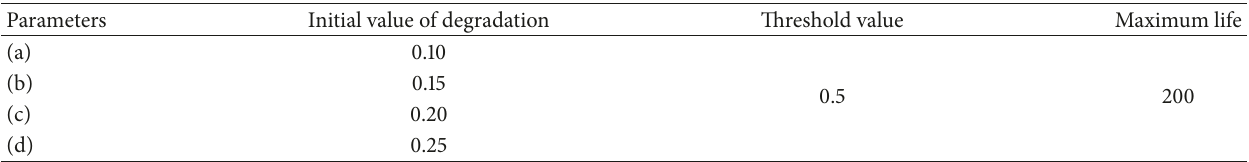
Table 2: Parameters setting.